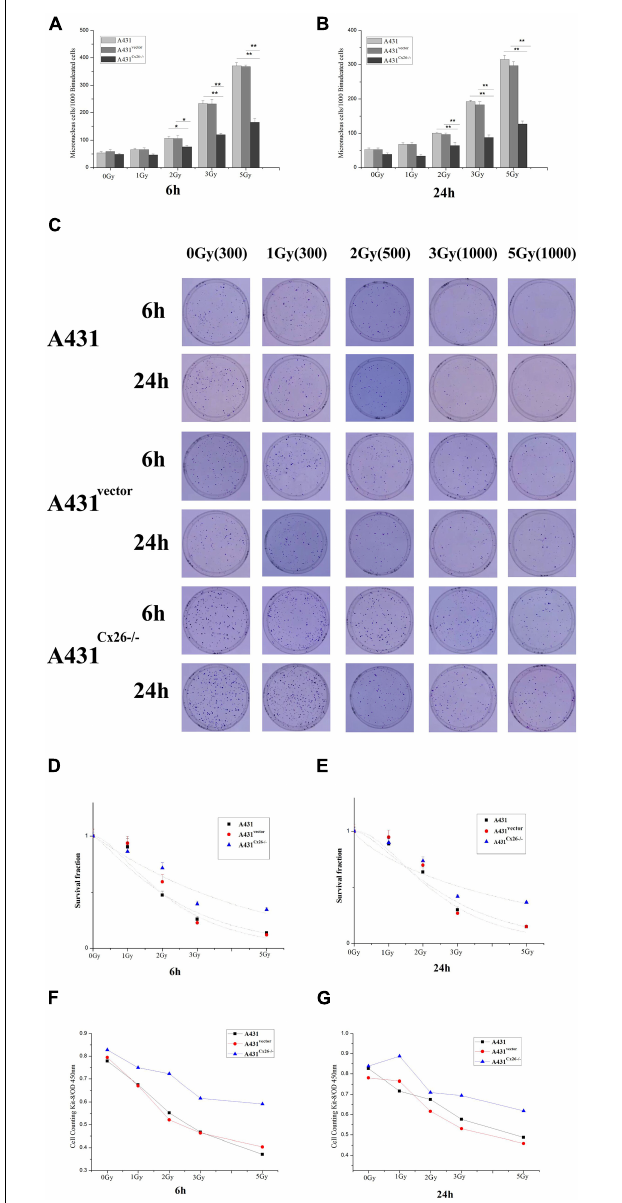
FIGURE 4 | Micronuclei and colony formation assays in irradiated A431, A431 vector , and A431 Cx26 − / − cells. (A) Statistical analysis of micronuclei formation in A431, A431 vector , and A431 Cx26 − / − cells 6 h after irradiation. (B) Statistical analysis of micronuclei formation in A431, A431 vector , and A431 Cx26 − / − cells 24 h after irradiation. (C) Quantification of clone formation in A431, A431 vector , and A431 Cx26 − / − cells 6 and 24 h after irradiation. (D) Dose-survival curves for A431, A431 vector , and A431 Cx26 − / − cells 6 h after irradiation; D 0 (A431 6 h) = 2.2214, N = 1.2845; D 0 (A431 vector 6 h) = 1.6945, N = 1.8206; D 0 (A431 Cx26 − / − 6 h) = 4.0250, N = 1.0966. (E) Dose-survival curves for A431, A431 vector , and A431 Cx26 − / − cells 24 h after irradiation, D 0 (A431 24 h) = 2.0667, N = 1.7154; D 0 (A431 vector 24 h) = 1.5955, N = 2.3482; D 0 (A431 Cx26 − / − 24 h) = 5.9810, N = 0.7704. (F) OD values for A431, A431 vector , and A431 Cx26 − / − cells 6 h after irradiation, as detected by CCK-8 assay. (G) OD values for A431, A431 vector , and A431 Cx 26 − / − cells 24 h after irradiation, as detected by CCK-8 assay. * p <0.05, ** p <0.01 between each cell